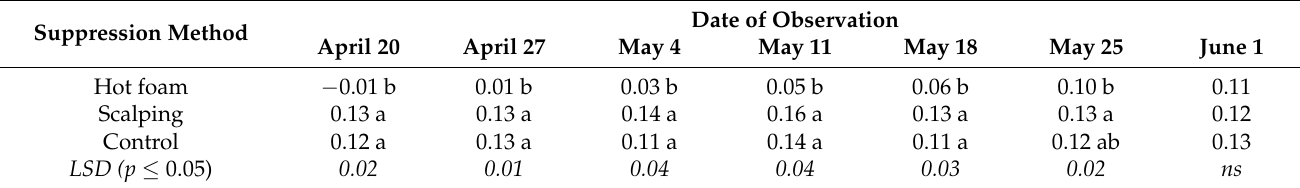
Table 4. Green Leaf Index (GLI): mean effect of Lolium perenne suppression method.